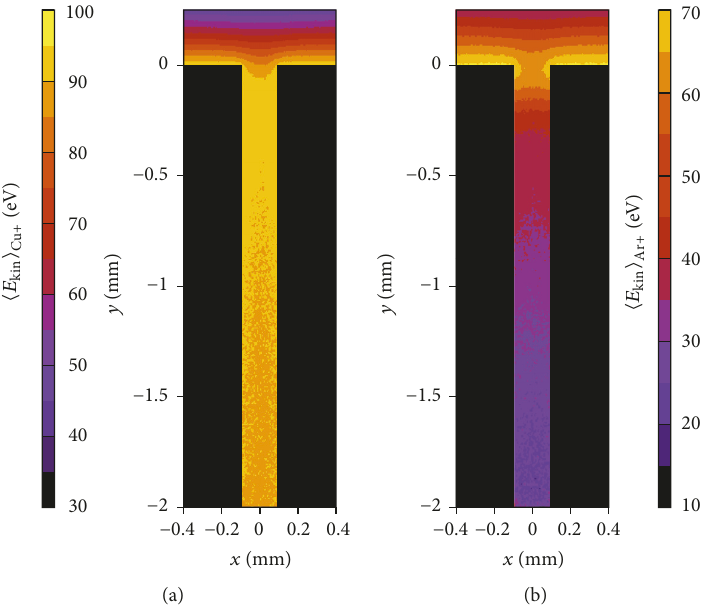
Figure 4: Mean energy of (a) Cu + and (b) Ar + ions inside the